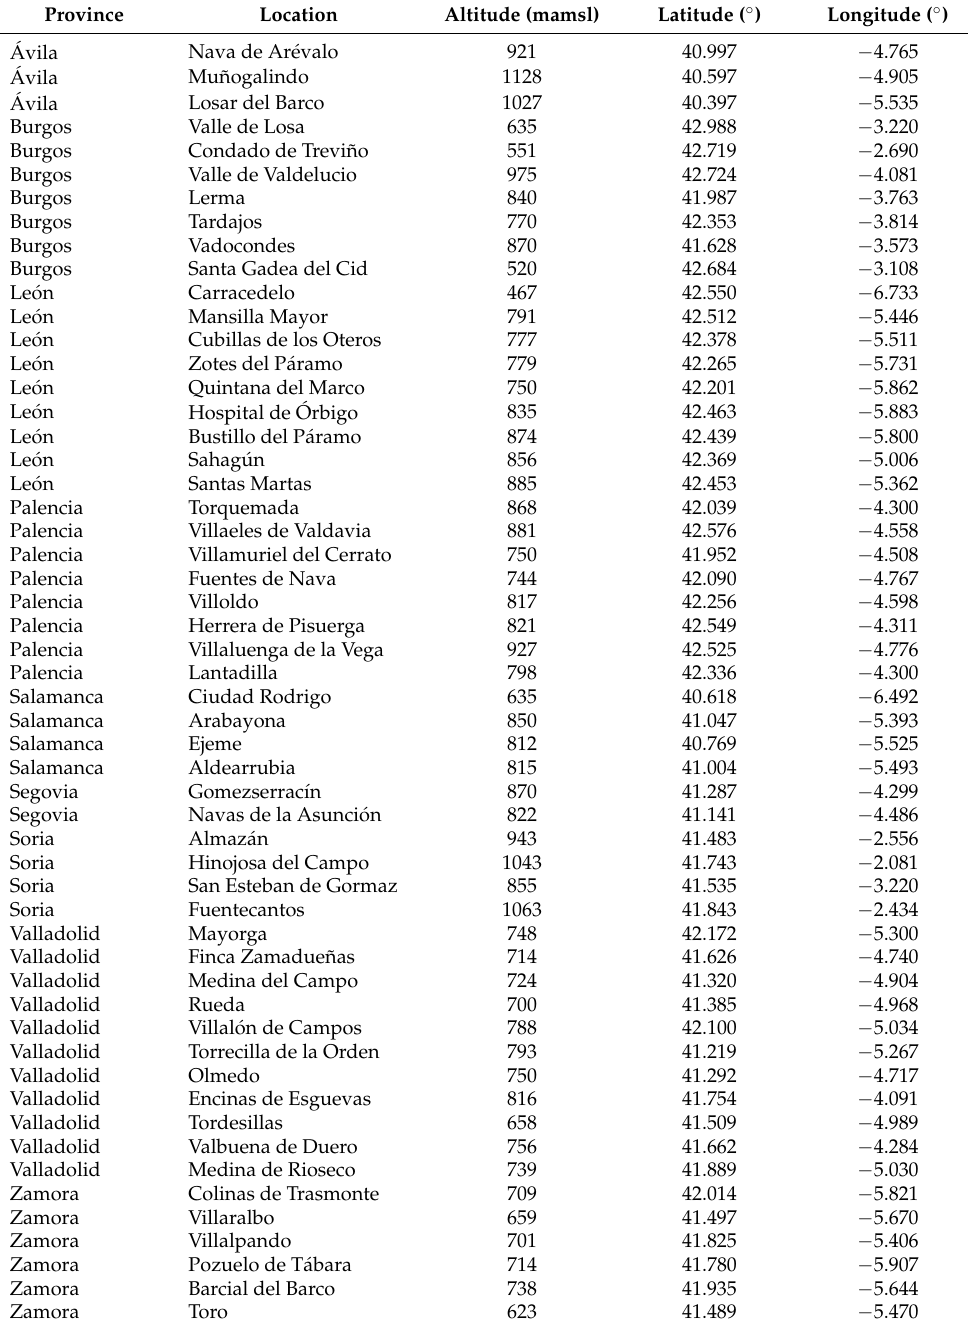
Table A1. Location of the 54 agrometeorological stations belonging to the Agro-climatic Information System for Irrigation (SIAR) located in Castilla and Le ó n Region,